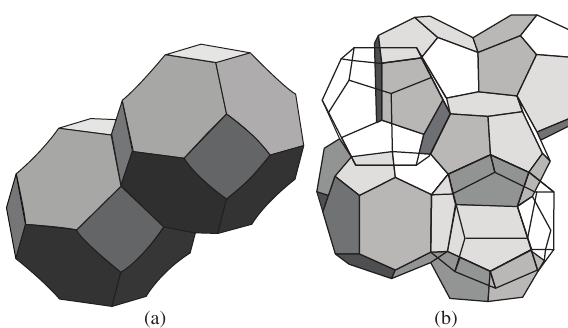
Figure 5. a) Kelvin’s “relaxed” tetrakaidecahedra. Illustration suggests how the flatfaced version of these polyhedra would stack by translation to tessellate 3-d space and form a body-centered cubic (BCC) lattice. BCC lattice points would be located at the centroids of each Kelvin cell; and b) The